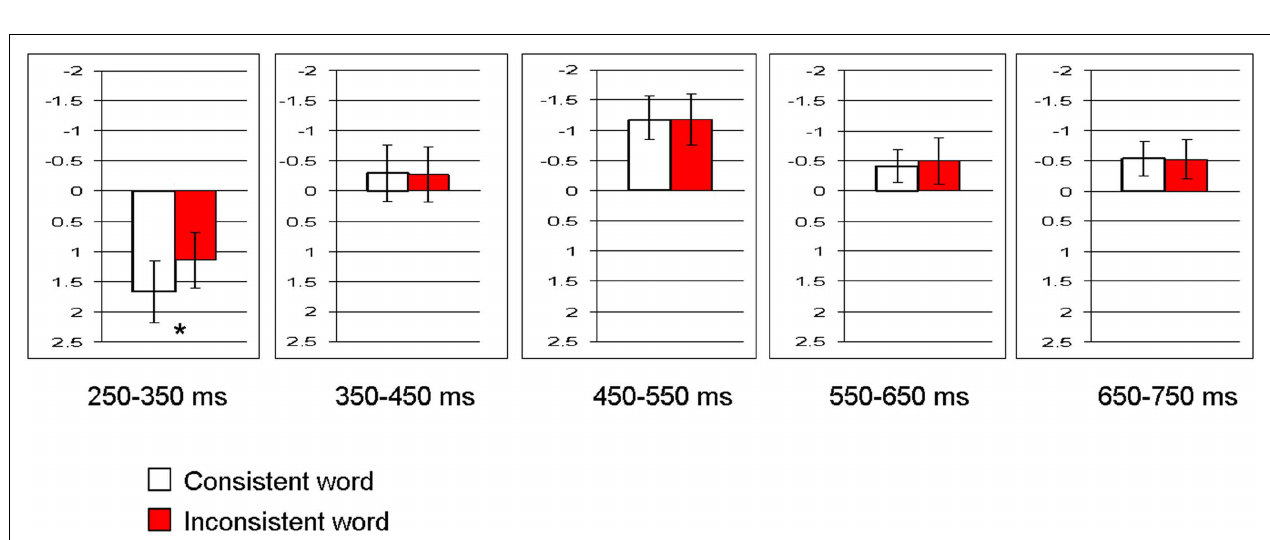
FIGURE 2 | Event-related brain potentials to consistent and inconsistent words from selected electrodes in left posterior quadrant.